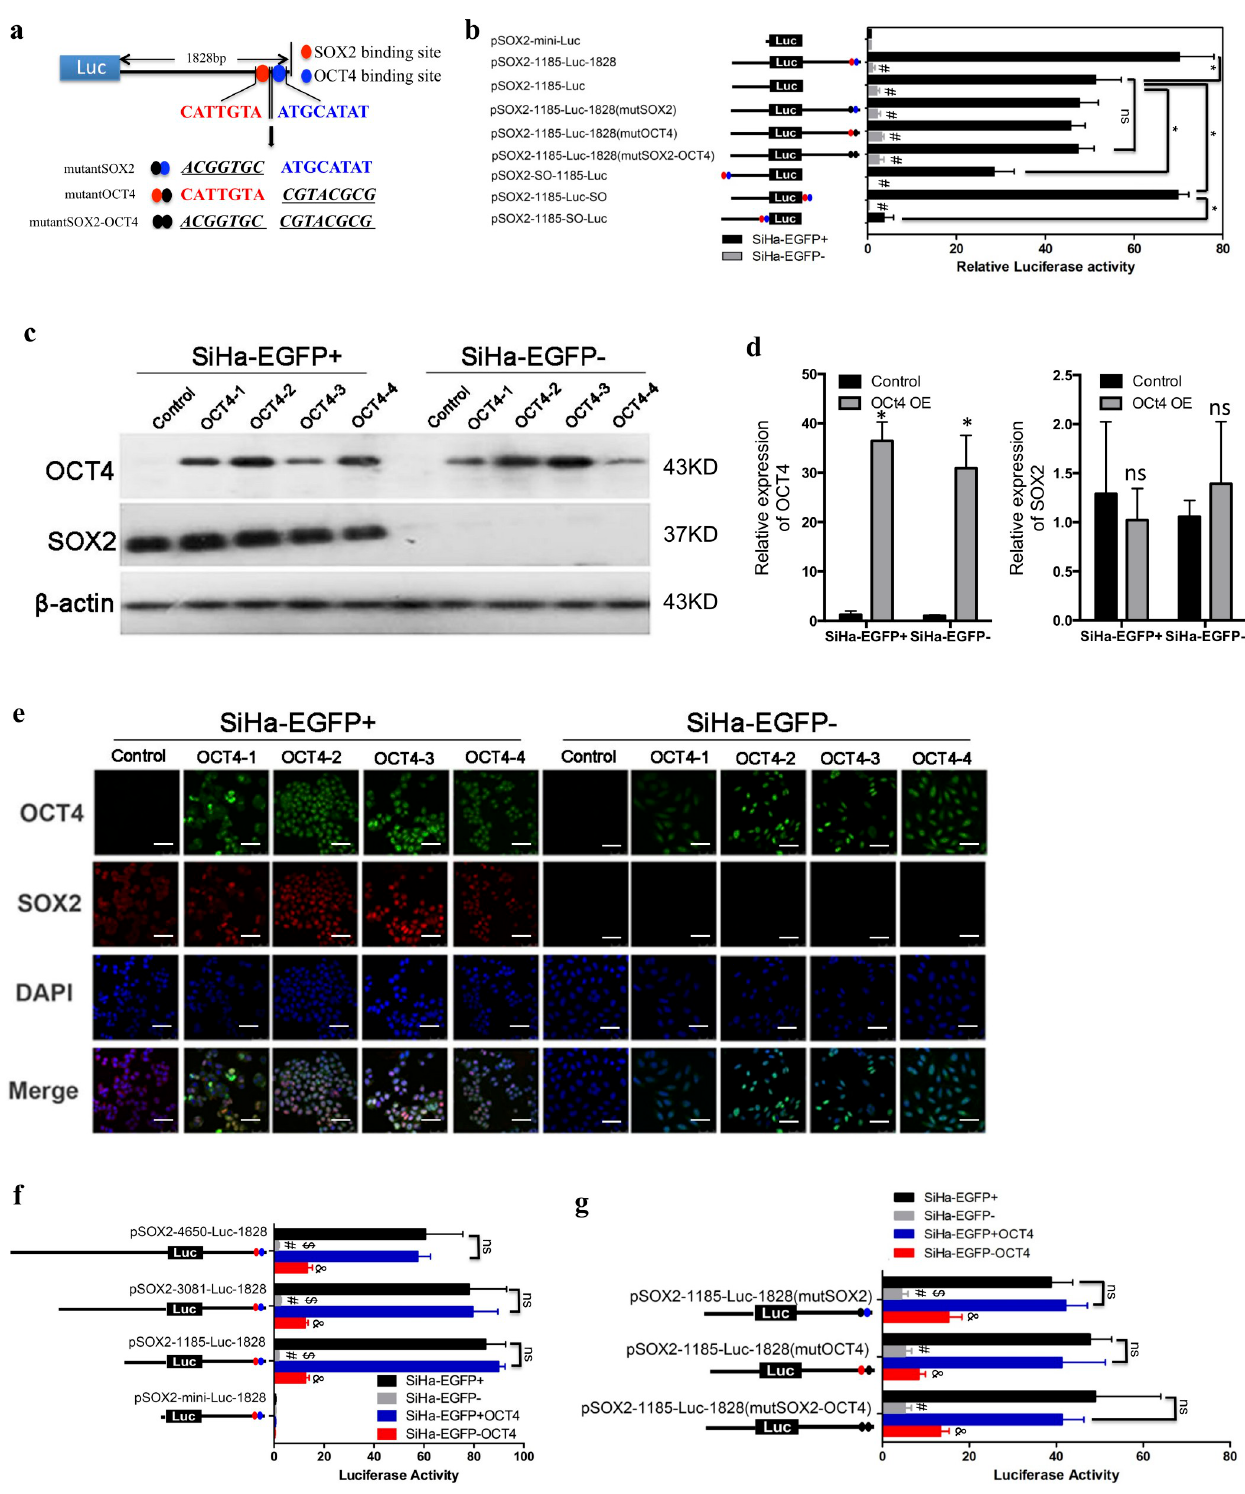
Fig 3. OCT4 partially increased SOX2 transcriptional activation. (a) The mutations of SOX2 and OCT4 binding sites downstream of the SOX2 promoter 3’UTR. (b) The luciferase activity of mutations in SOX2 promoter was detected. (S: SOX2; O: OCT4; red dot: SOX2 binding site; blue dot: OCT4 binding site; black dot: mutant of SOX2 or OCT4 binding site). The expression level of OCT4 was detected in OCT4-overexpressing SiHa-EGFP+ and SiHa-EGFP- cells by Western blot including densitometric analysis (c and d) and immunofluorescence (e). (f and g) The luciferase activity of the SOX2 promoter deletions and